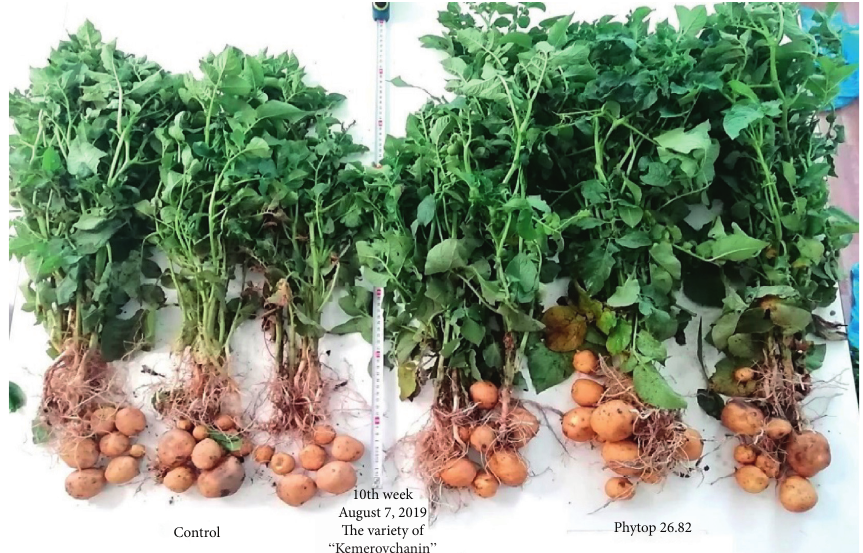
Figure 5: The influence of microbial agents on forming the aboveground and underground parts of potatoes 2.5 months after planting, i.e., on the 10th counting week. Potato treated with the biological product Phytop 26.82 looks persistent and robust. The stems are tall, the leaf surface is vast, and there are many tubers compared to the other two variants. Table 5: The influence of the biological product Phytop 26.82 on soil microflora indicators for the two variants.